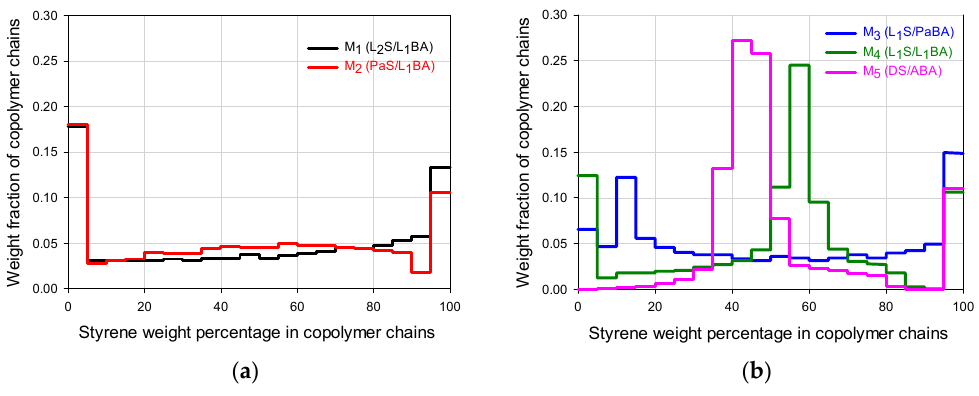
Figure 2. Weight fraction of copolymer chains of FCCs as a function of styrene weight percentage in the copolymer chains, estimated for: ( a ) M 1 , and M 2 , materials and ( b ) M 3 , M 4, and M 5 materials. For codes, see Figure 1.